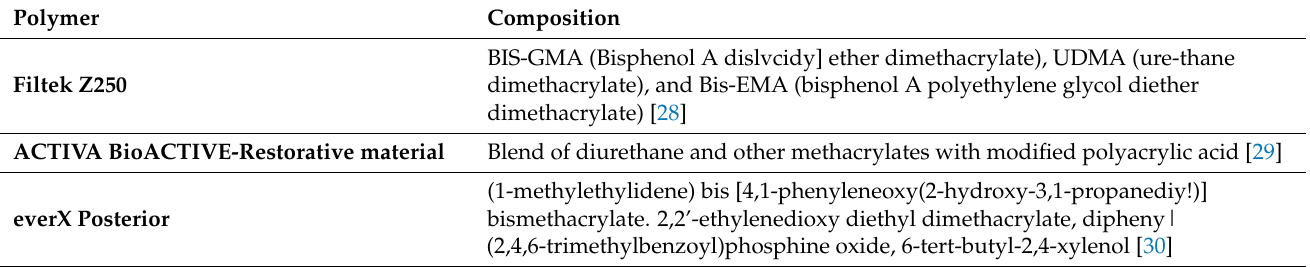
Figure 3. Distribution of the six groups for maximum load testing. Table 1. Composition of the matrix of polymer materials used in the